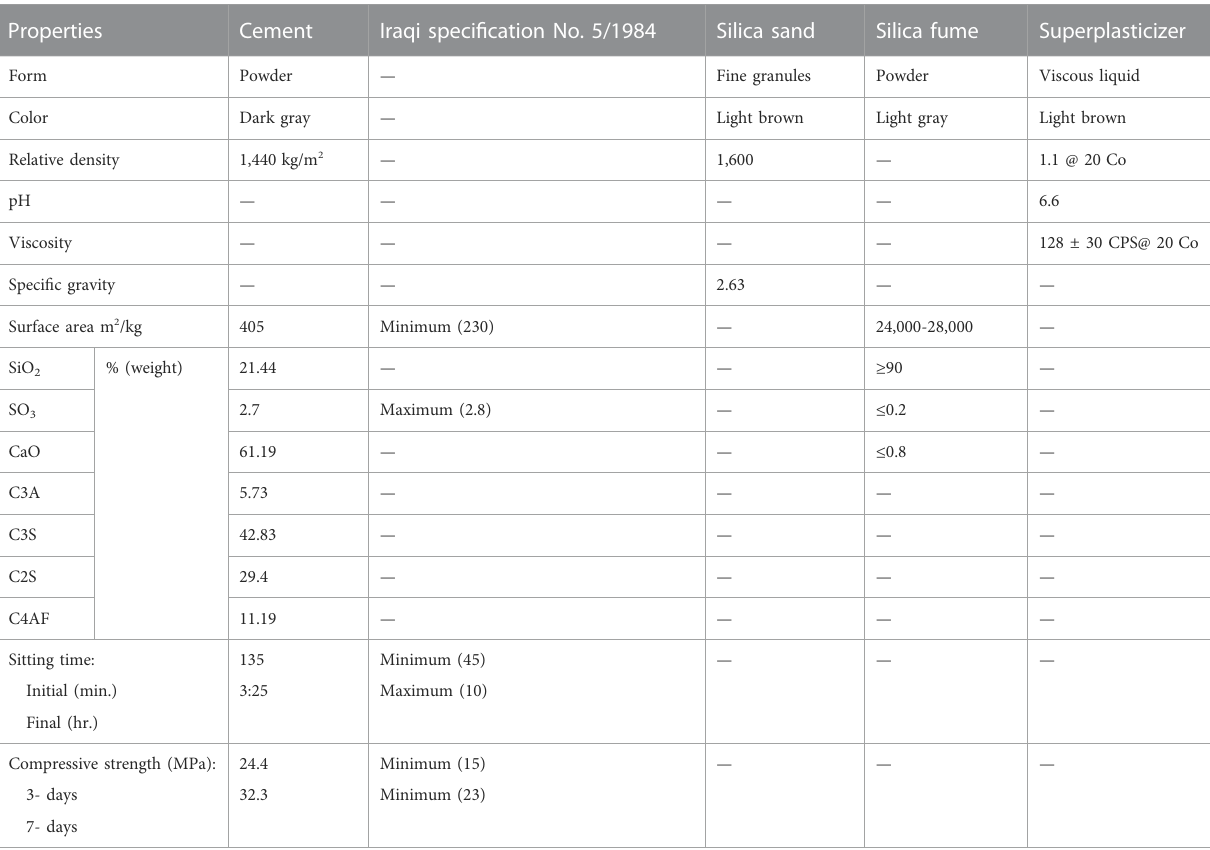
TABLE 2 Material properties used in the current study.